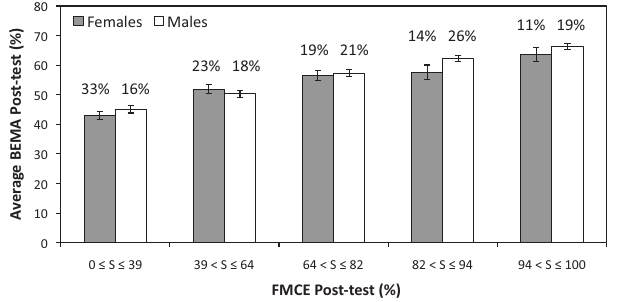
FIG. 5. Average BEMA post-test scores for females and males with matched FMCE post-test scores (cid:1) N =1117 (cid:2) . The percentages above each bar represent the percentage of the females (cid:1) or males (cid:2) from the total in each bin. The error bars represent the standard error on the mean. The differences between males and females are not significant (cid:1) p (cid:2) 0.05 (cid:2) in all five of the